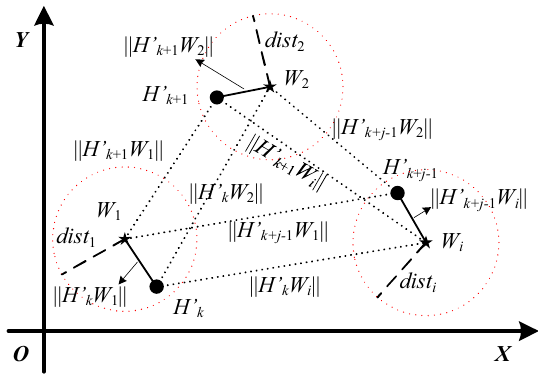
Figure 7. Principle map of physical-layer channel